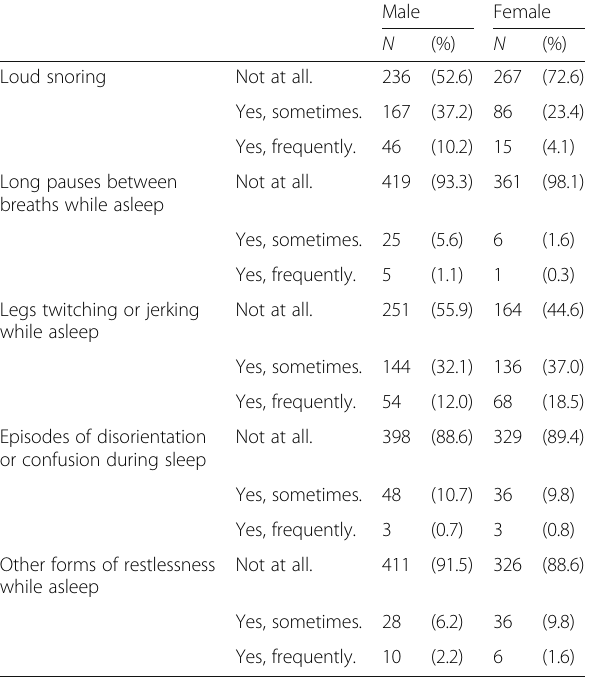
Table 3 Results of the Pittsburgh sleep quality index (PSQI) global and subcategories and Epworth Sleepiness Scale (ESS) scores